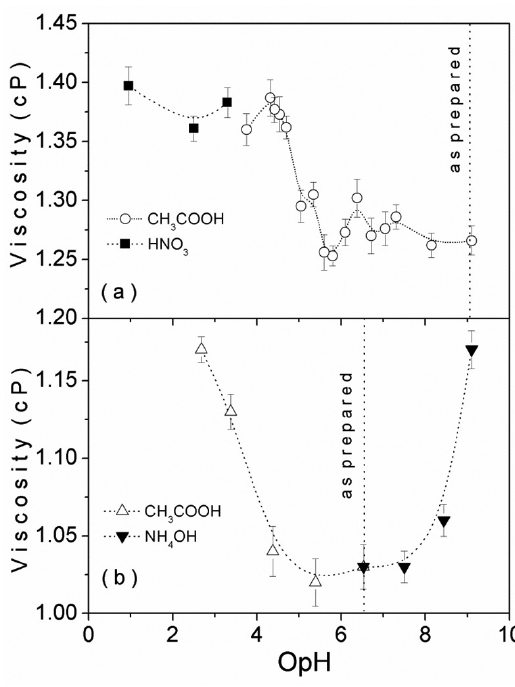
Figure 1. Effect of OpH (operational pH) on the viscosity for the (a) EtOH and (b) EtOH+Acac suspensions (0.5 g BTZ-100 mL